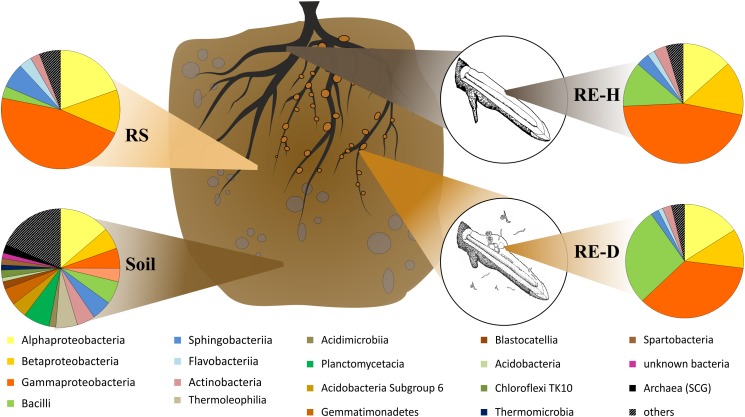
Microbial composition on class level within the four microhabitats. In diseased rhizoendosphere (RE-D), mainly Bacilli and Gammaproteobacteria change in their abundances compared to healthy rhizoendosphere (RE-D). RE-D, Meloidogyne-diseased rhizoendosphere; RE-H, healthy rhizoendosphere; RS, rhizosphere.